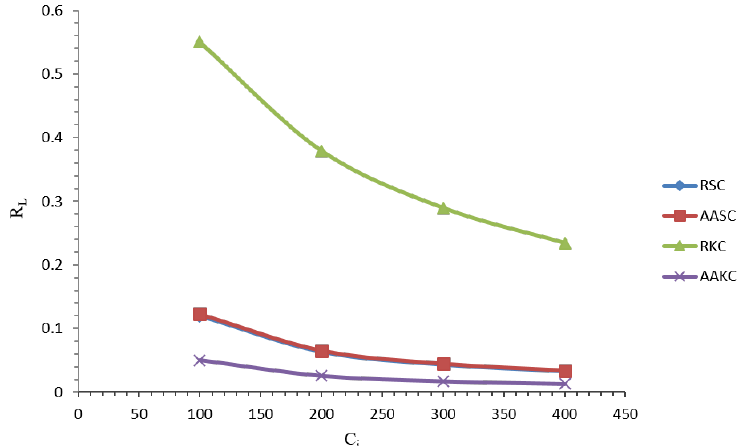
: (RSC-Raw Siththandy Clay, AASC- Acid Activated Siththandy L